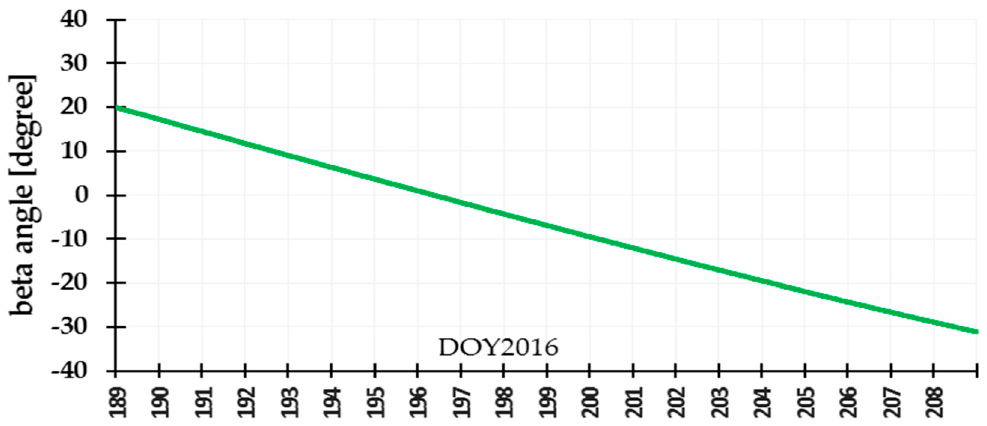
Figure 2. Beta angles variation for Jason-3 satellite.